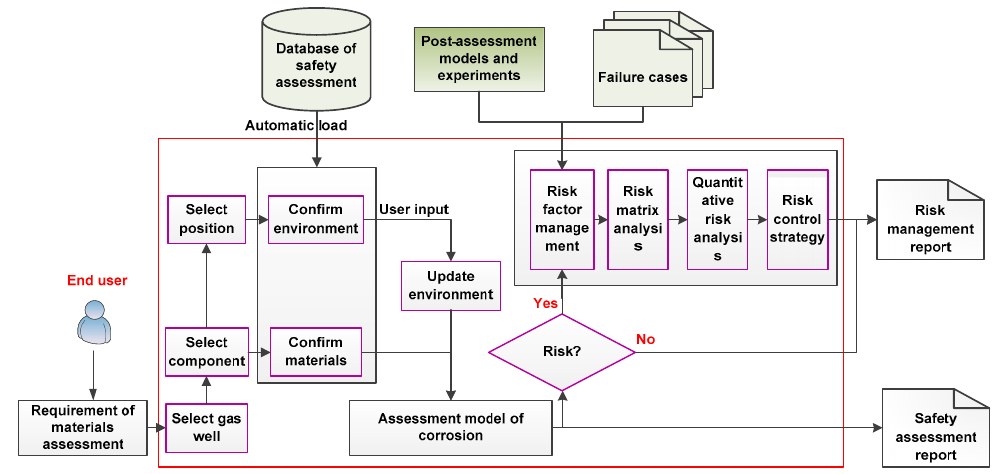
Figure 7. Business flowchart of petrochemical platform.